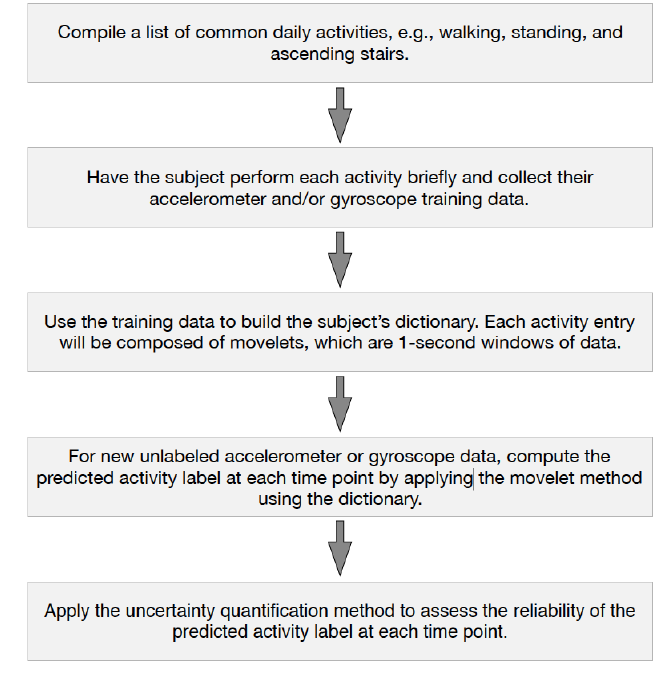
Figure 1. Outline of the augmented movelet